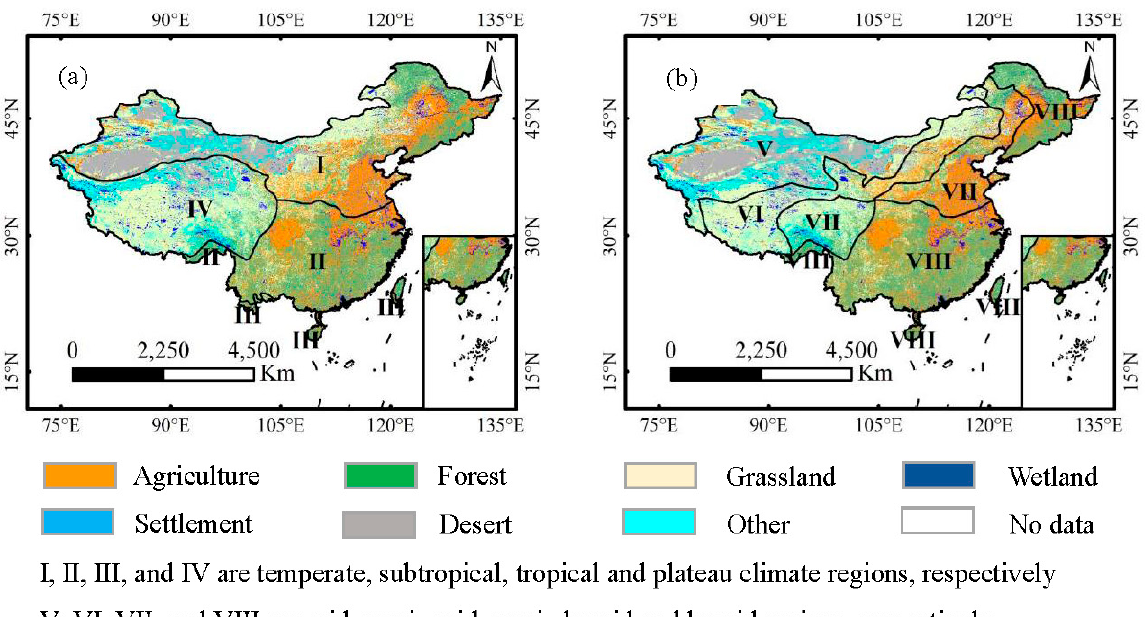
Figure 1. The climate zones ( a ) and moisture regions ( b ) of China.